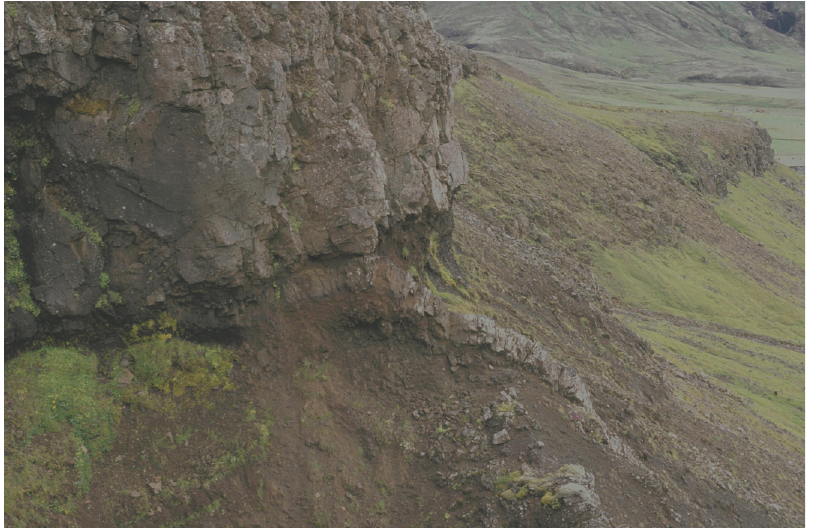
Fig. 11. Inclined, 0.5-1 m thick sheet in the Pleistocene lava pile in Southwest Iceland. The contact between the weak scoria (below) and the basaltic lava flow (on the top) has opened up, so as to allow the sheet to follow it for several metres until the sheet continues its inclined propagation up through the lava flow on the top. Open- ing of weak contacts when magma-filled fractures approach them is a common feature, as is modelled in fig.